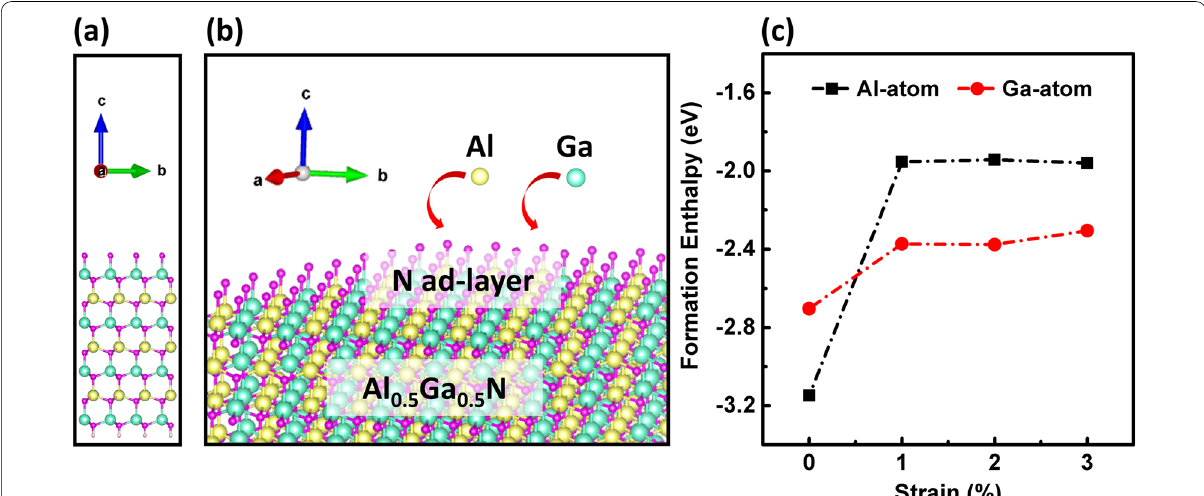
Fig. 5 a Al 0.5 Ga 0.5 N slab model generated by 4 a or Ga atom adsorbed onto the surface with N ad-layer. c Formation enthalpy of Al atom and Ga atom adsorbed onto the Al 0.5 Ga 0.5 N surface as a function on the tensile strain